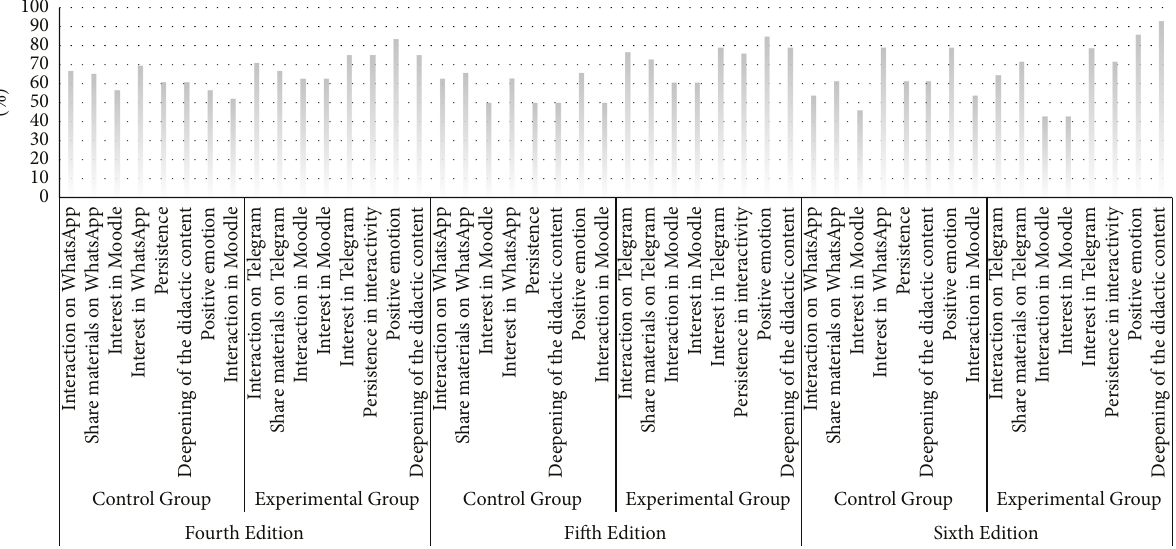
Figure 5: Distribution of student behavior according to control and experimental groups (last three editions of the virtual course).